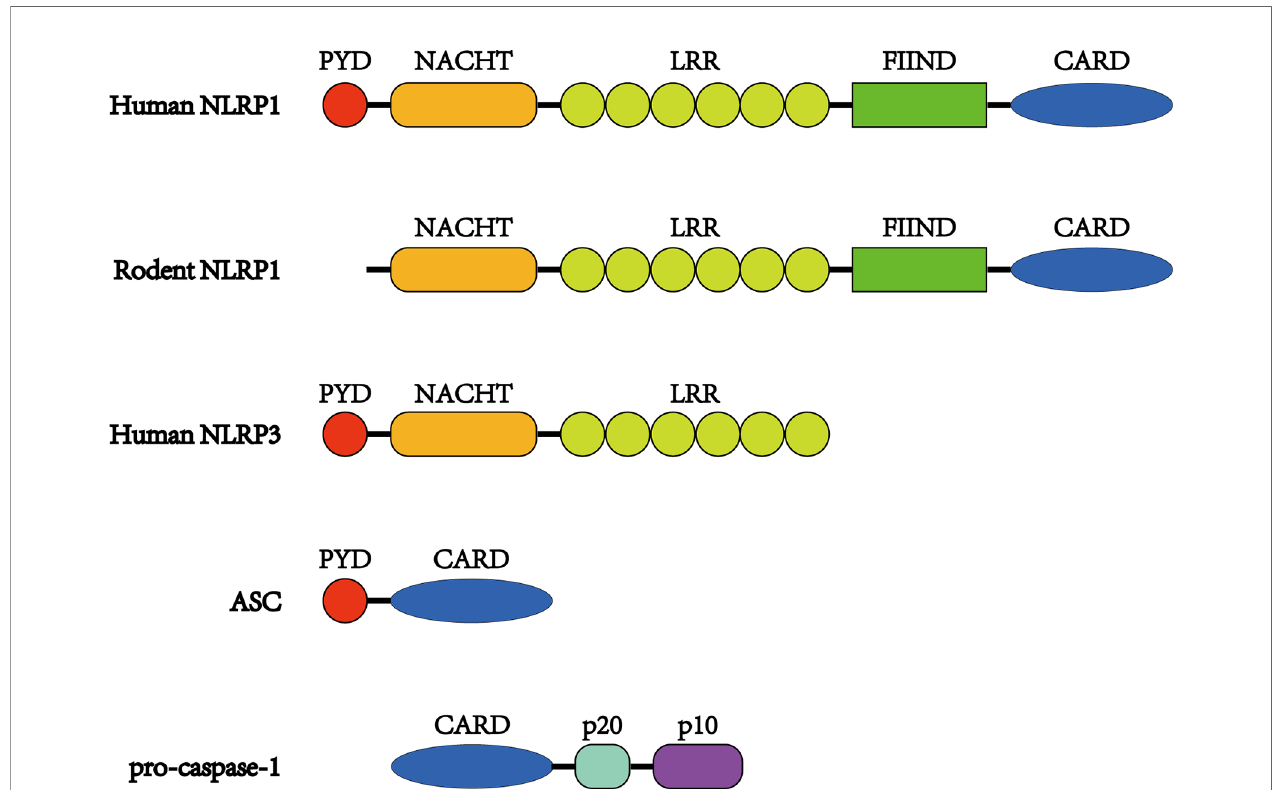
FIGURE 1 | Structures of NLRP1 in fl ammasome proteins. Unlike other NLRs, NLRP1 proteins have a FIIND and CARD at the C-terminus. The FIIND consists of ZU5 and UPA subdomains, and autoproteolysis takes place between them. In addition, NLRP1 proteins contain NACHT and LRR domains preceding the FIIND. Human NLRP1 also possesses a PYD domain at the N-terminus, which is absent in its rodent orthologs. ASC consists of a PYD and CARD, while pro-caspase-1 possesses a CARD before its catalytic p20 and p10